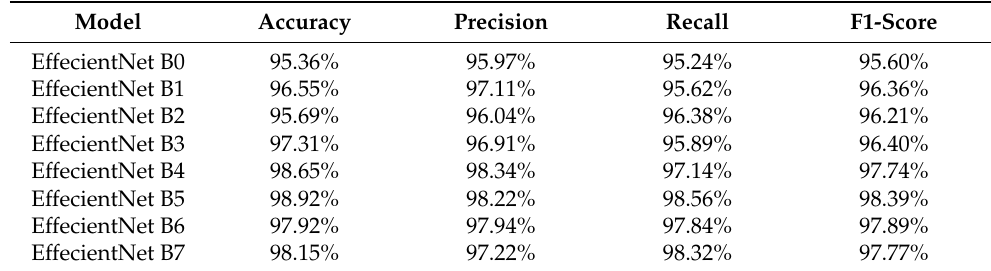
Table 2. Results for pavement defect detection on original dataset.